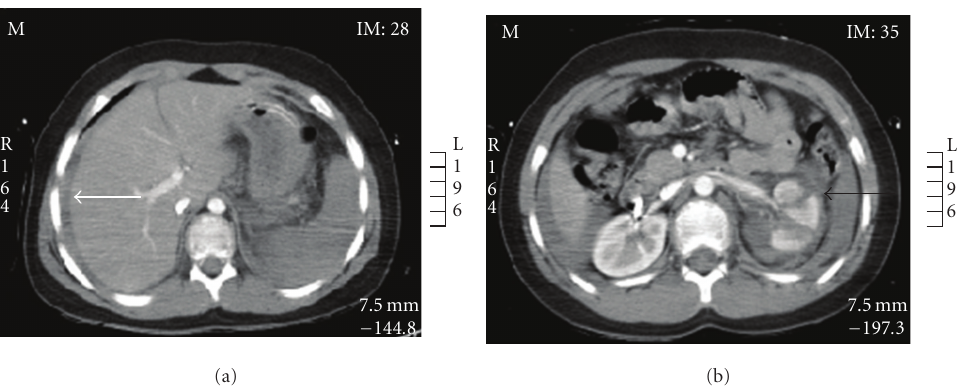
Figure 1: CT scan of the abdomen in portal venous phase showing fluid around the liver (white arrow), di ffi cult to appreciate any splenic change. Lacerated left kidney with perinephric haematoma (black arrow).